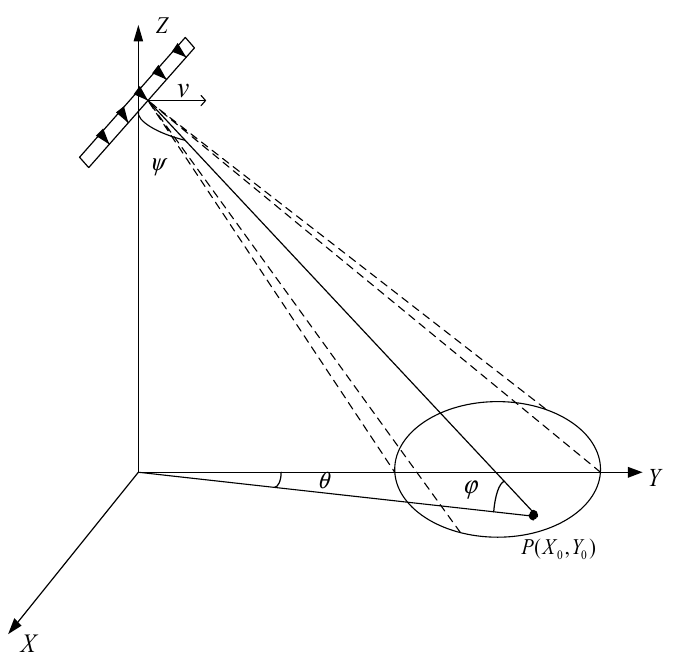
Figure 2. Geometry of the frequency diverse array synthetic aperture radar (FDA-SAR).